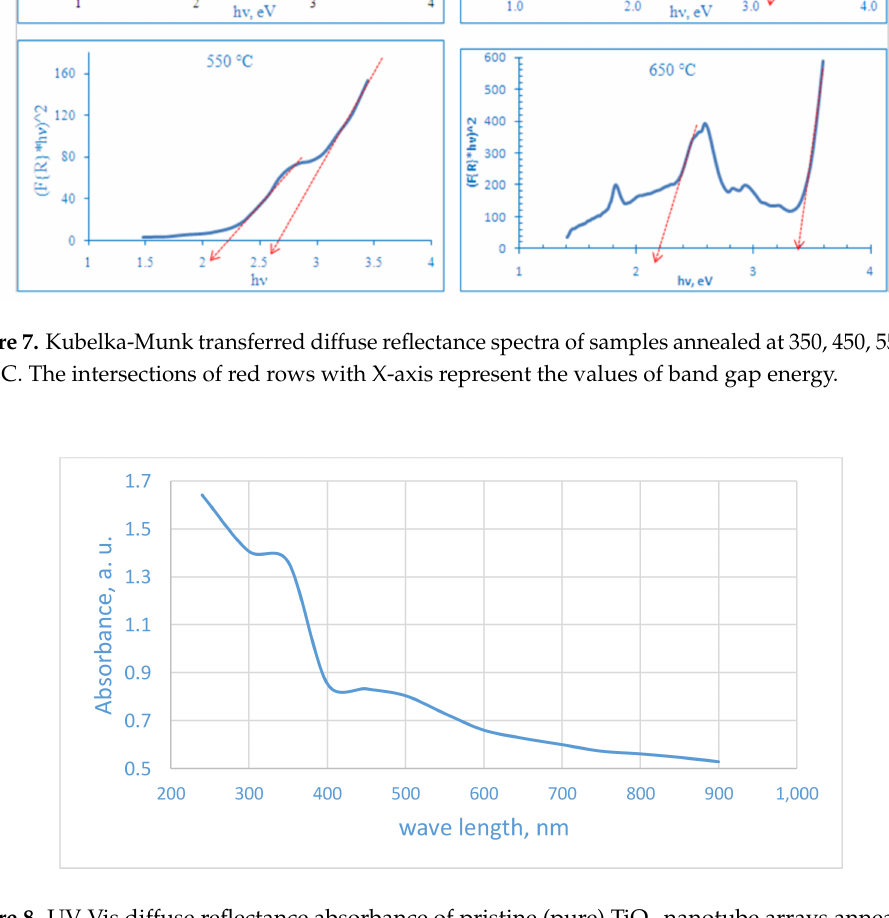
Figure 8. UV-Vis diffuse reflectance absorbance of pristine (pure) TiO 2 nanotube arrays annealed at 550 ◦ C. Table 1. The band gap energies (E g ) and corresponding absorbance edges of TiO 2 nanotube arrays annealed at different